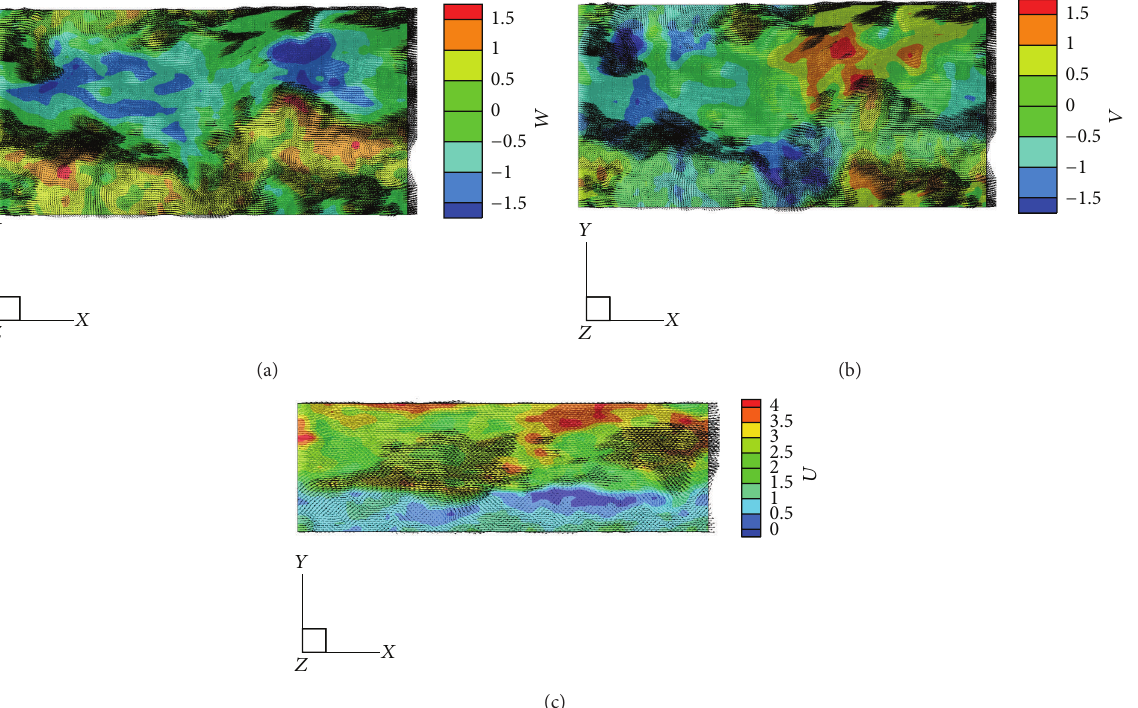
Figure 4: Instantaneous velocity contour plots with velocity vectors: (a) 𝑊 velocity with slice plane at 𝑍 = 25 m; (b) 𝑉 velocity, slice plane at 𝑍 = 25 m; and (c) 𝑈 velocity, slice plane at 𝑌 = 48